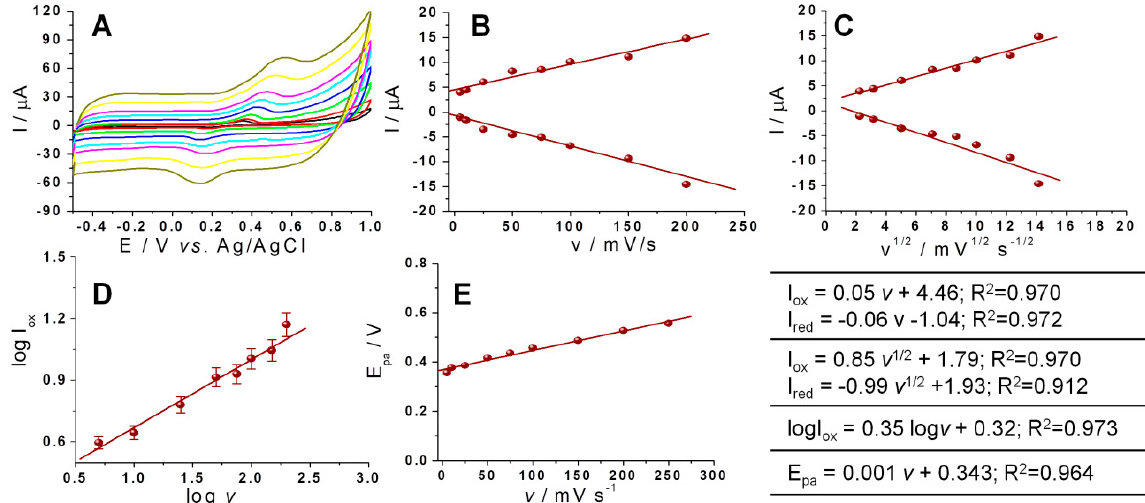
Figure 5. ( A ) Voltammograms registered for 100 µ g/mL DOX solution in PB of pH 5 with 25% EtOH, using graphite SPE and different scan rates (5 mV/s: black; 10 mV/s: red; 25 mV/s: green; 50 mV/s: blue; 75 mV/s: light blue; 100 mV/s: pink; 150 mV/s: yellow and 200 mV/s: brown). The variation of the current peak intensity with the: ( B ) scan rate; ( C ) square root of the scan rate. ( D ) The variation of logI ox with log v. ( E ) The variation of the oxidation potential with the scan rate. Inset in the right corner: equations of the above-mentioned correlations. Error bars were calculated based on the standard deviation obtained for 3 tests on 3 different electrodes.